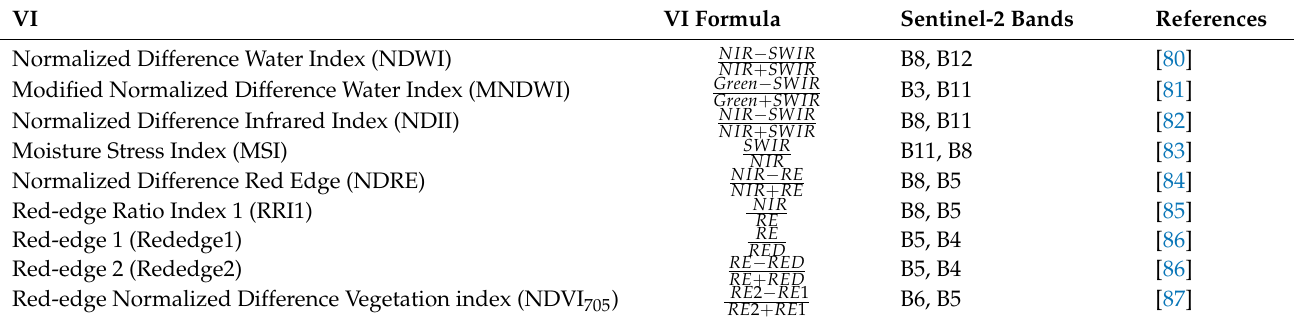
Table 1. Spectral vegetation indices used in this